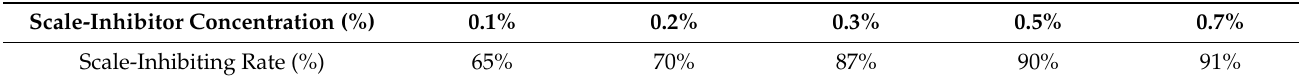
Table 4. Scale-inhibition rate for CaSO 4 of SC-1 at different